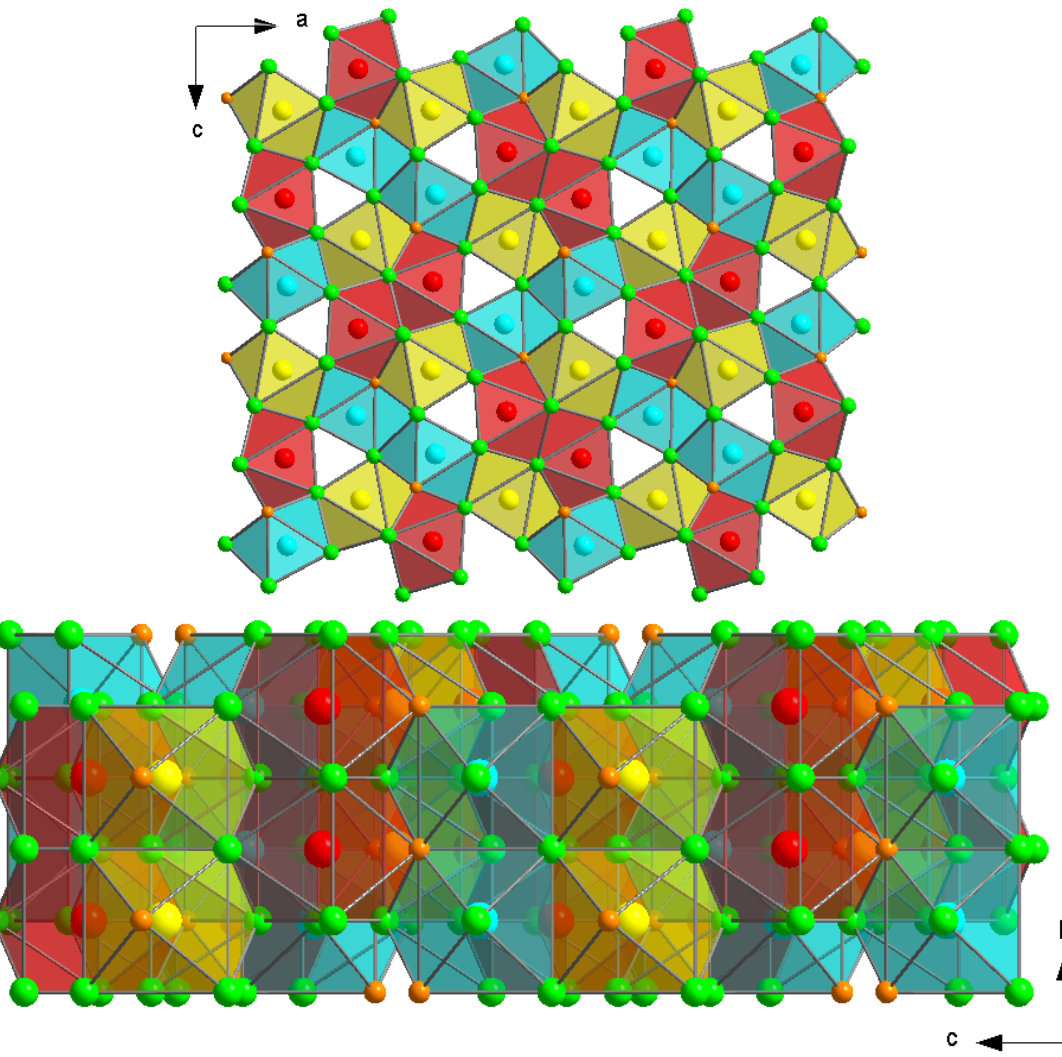
Te Br; projections down [010] (top) and [100] 3 4